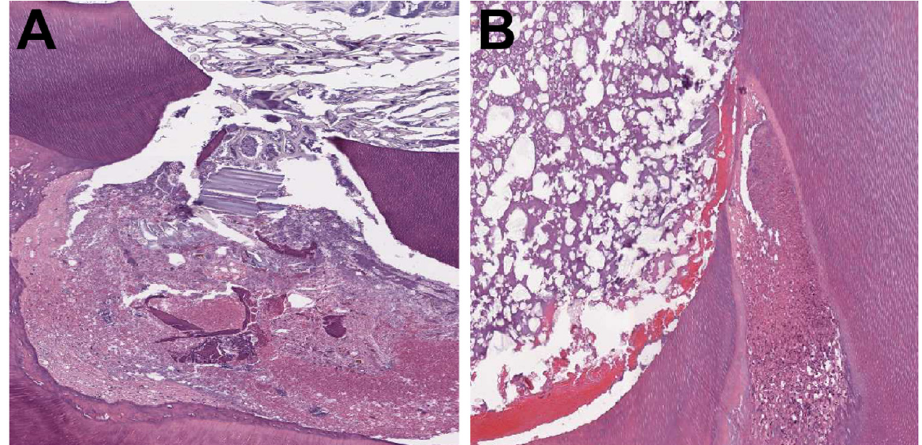
Figure 3. Histologic features of maxillary first molars subjected to pulp exposure and restored with glass ionomer without the use of pulp capping agent at week four. Representative photomicrographs showing ( A ) pulpal degeneration and ( B ) calcified bridge formation. H&E ×200 magnification.